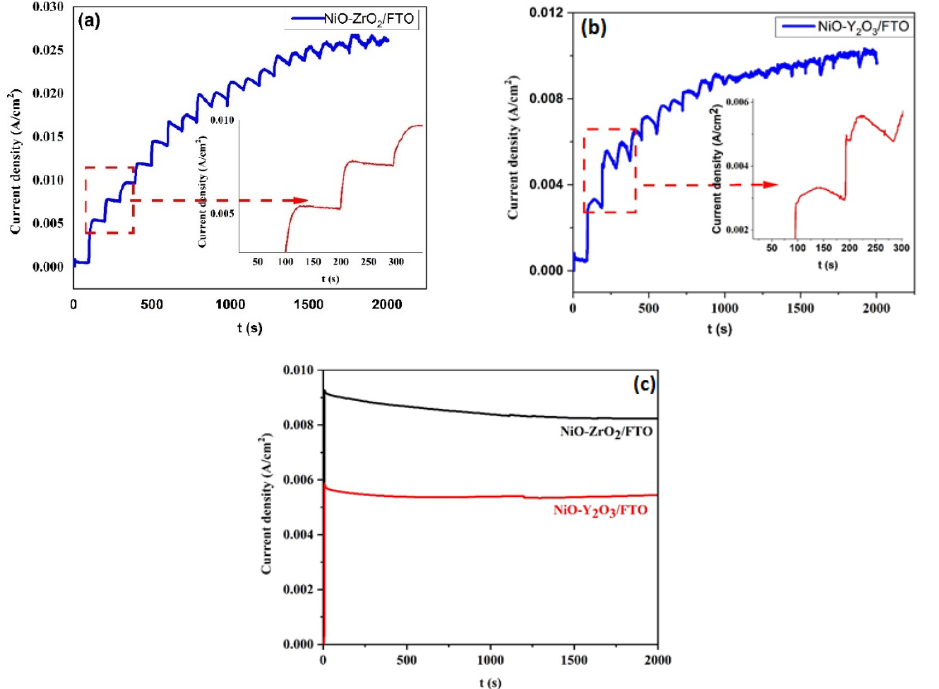
Figure 6. Current-time plot of ( a ) NiO-ZrO 2 /FTO and ( b ) NiO-Y 2 O 3 /FTO thin film in 0.5 M NaOH electrolyte solution at the addition of 0.2 M methanol solution after every 90 s at an applied potential of 0.6 V. ( c ) Current-time plot of NiO-ZrO 2 /FTO and NiO-Y 2 O 3 /FTO thin film in 0.5 M NaOH and 0.6 M methanol solution at an applied potential of 0.6V.